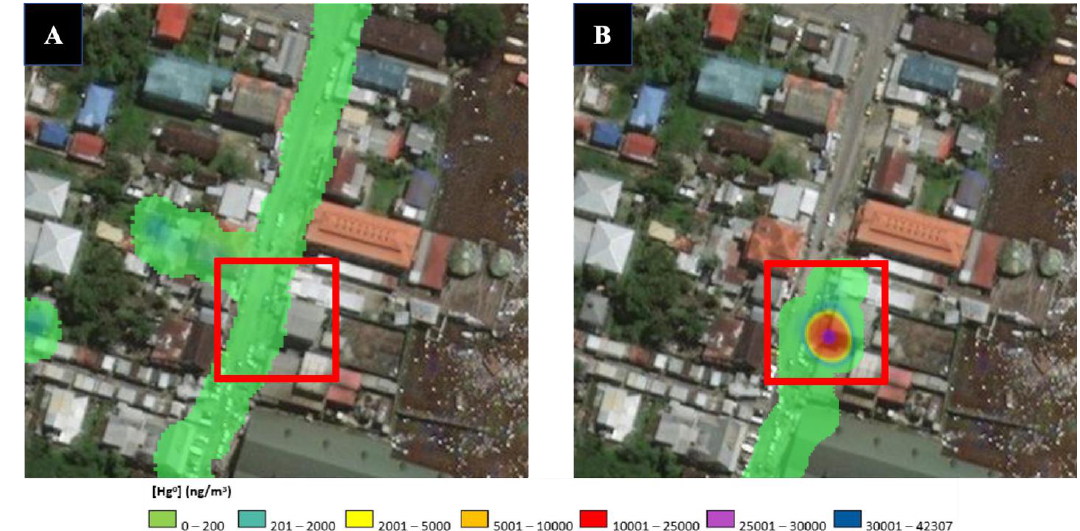
Figure 7. Panels ( A , B ) are daily maps generated by trainees. No burning activity (panel ( A )) may not be reflective of gold shop activity. When sponge gold or amalgams are heated in the same location in subsequent days, Hg 0 is clearly visible on the map (panel ( B